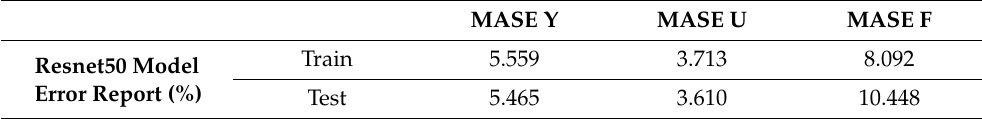
Table 8. ResNet50 error report for training and testing data after the HP optimization.